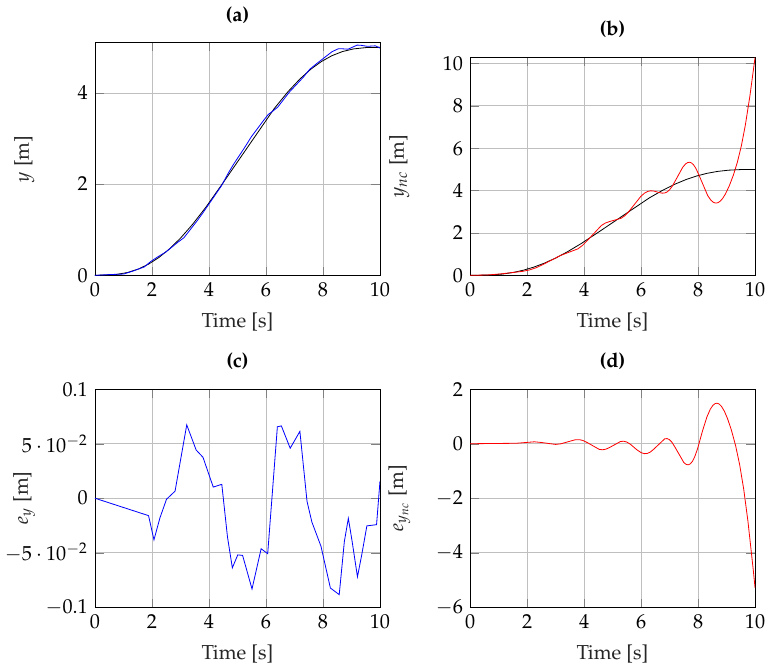
Figure 6. ( a ) Latitudinal motion of the UAV: the reference y ref (black), y with robust control (blue); ( b ) Latitudinal motion of the UAV: the reference y ref (black), y nc with non-robust control (red); ( c ) Latitudinal error motion of the UAV with robust control e y (blue); ( d ) Latitudinal error motion of the UAV with non-robust control e y nc